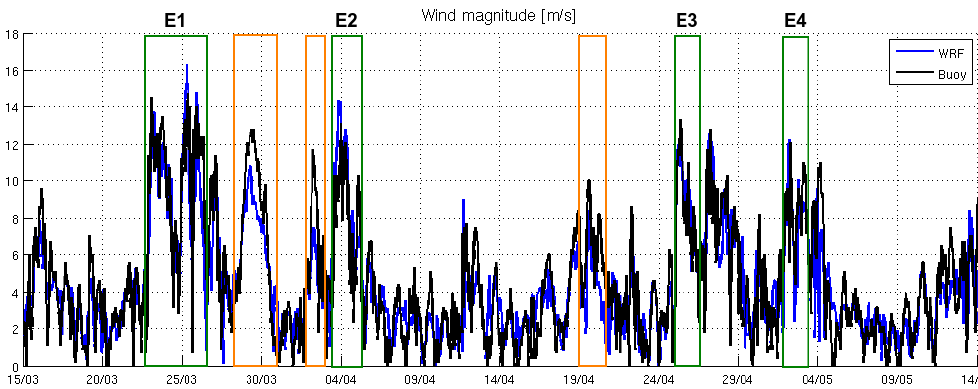
Figure 3. Wind magnitude measured at DB (black) compared with WRF model data (blue). The green boxes are the selected NW wind-jet events, and the orange boxes are the most underestimated wind events, which match easterly wind events. Time series data are for 2014.